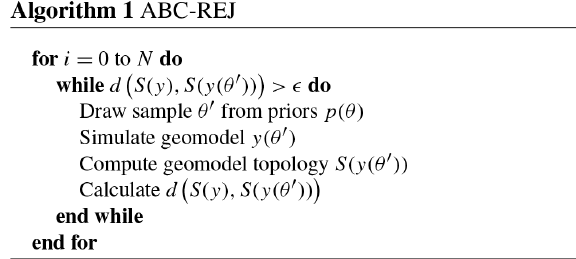
Figure 3. Vertical (a) and horizontal (b) difference matrix D show- ing all cells (red) in the shifted matrices S 1 and S 2 , which are next to the interface between two different layers or of any layers across a fault. The highlighted (yellow) part shows the area in which the implicit interface must be